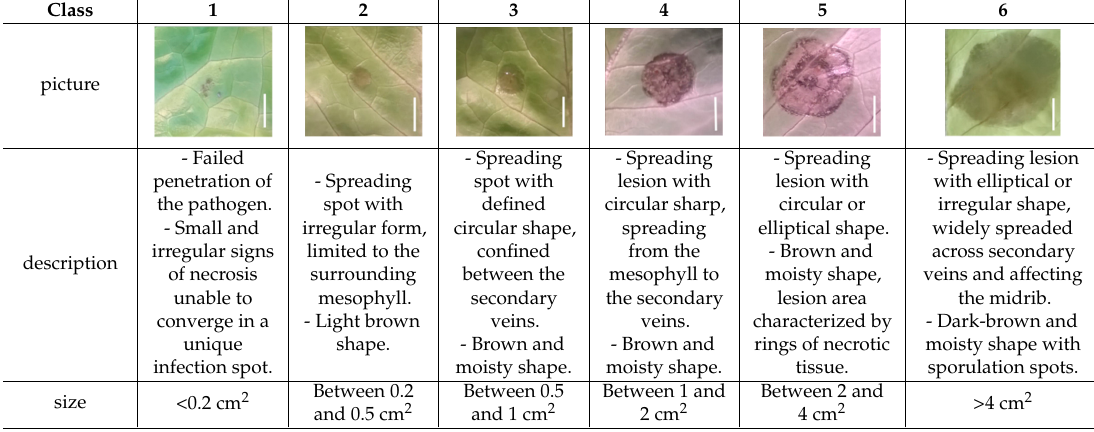
Figure 9. Schematic representation of the experimental design used for the priming and disease scoring performed in this study. Table 1. Description of the severity classes implemented in the disease scorings done in this work with corresponding representative pictures. Scale bars =1 cm.